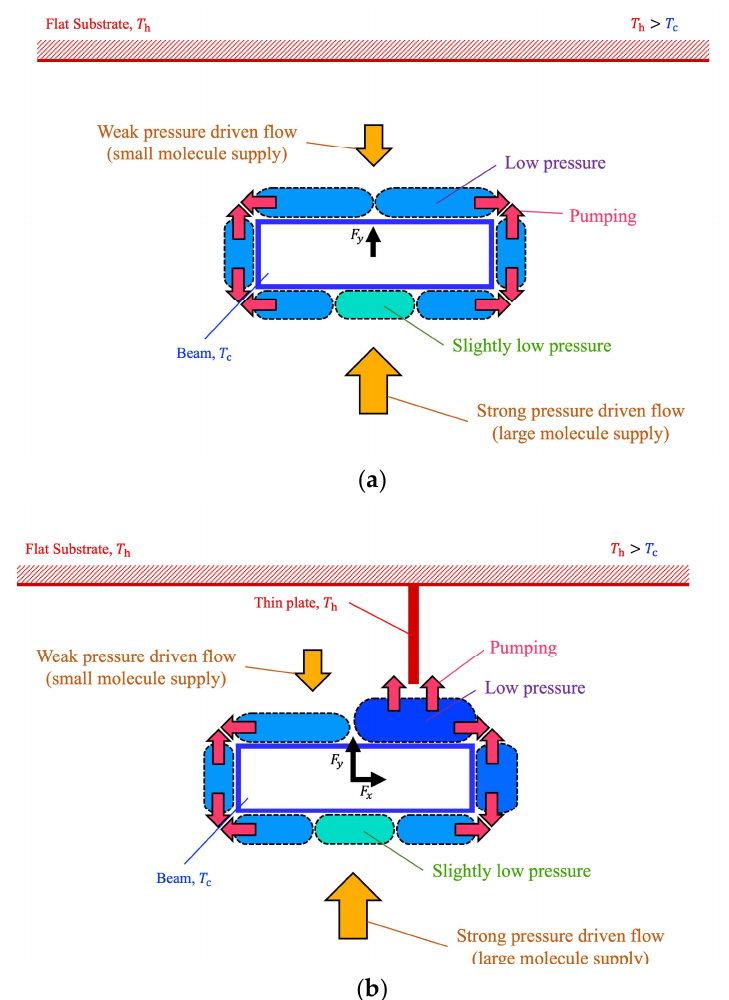
Figure 14. Schematic of the mechanism of the thermally induced forces on the beam ( a ) when the beam is placed close to a flat substrate and ( b ) when the beam is placed close to a heated thin plate mounted on a substrate.